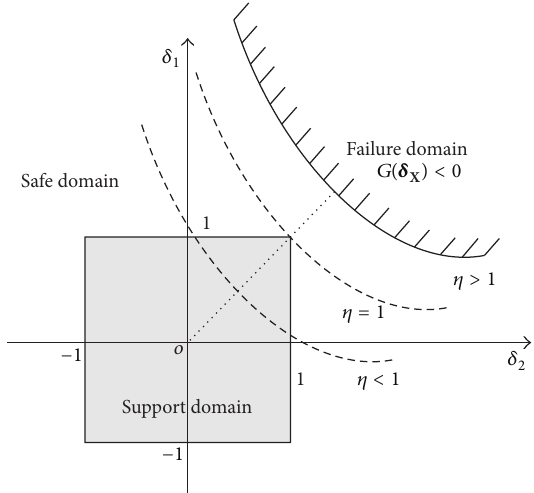
Figure 1: The nonprobabilistic reliability based on two-dimensional interval model.